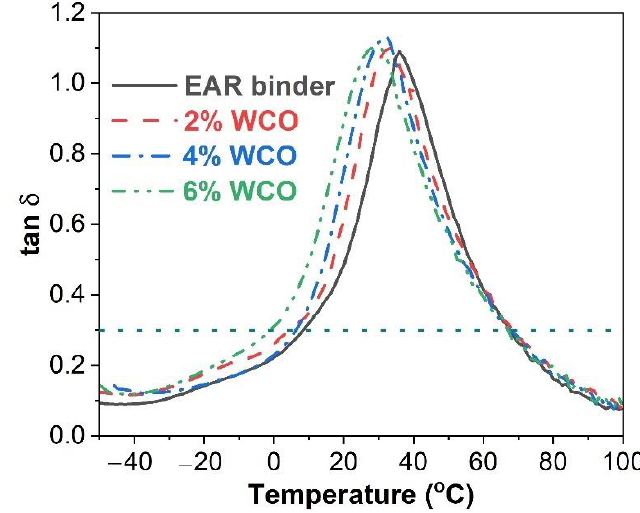
Figure 4. tan δ vs. temperature curves of the unmodified and WCO-modified EAR binders. Table 2. Glass transition temperatures and crosslink densities of the unmodified and WCO-modified EAR